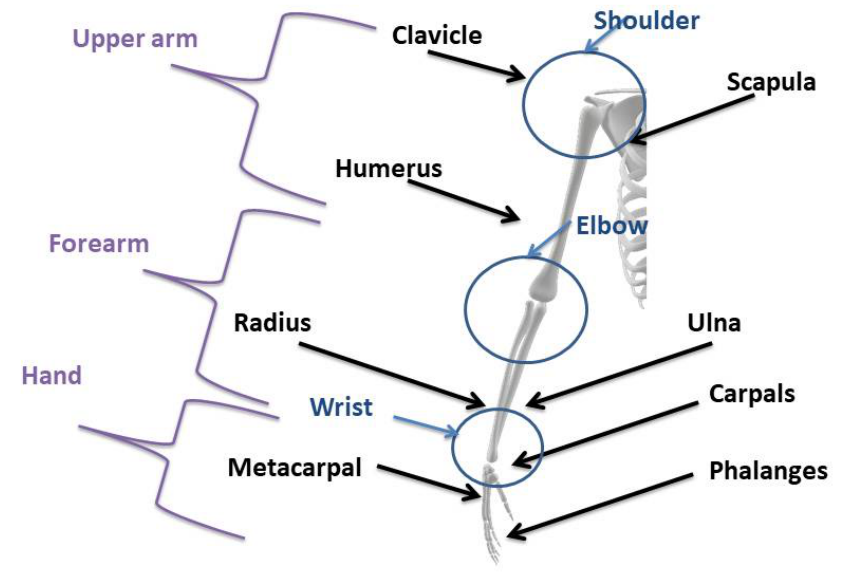
Figure 1. Anatomy of the human upper limb.